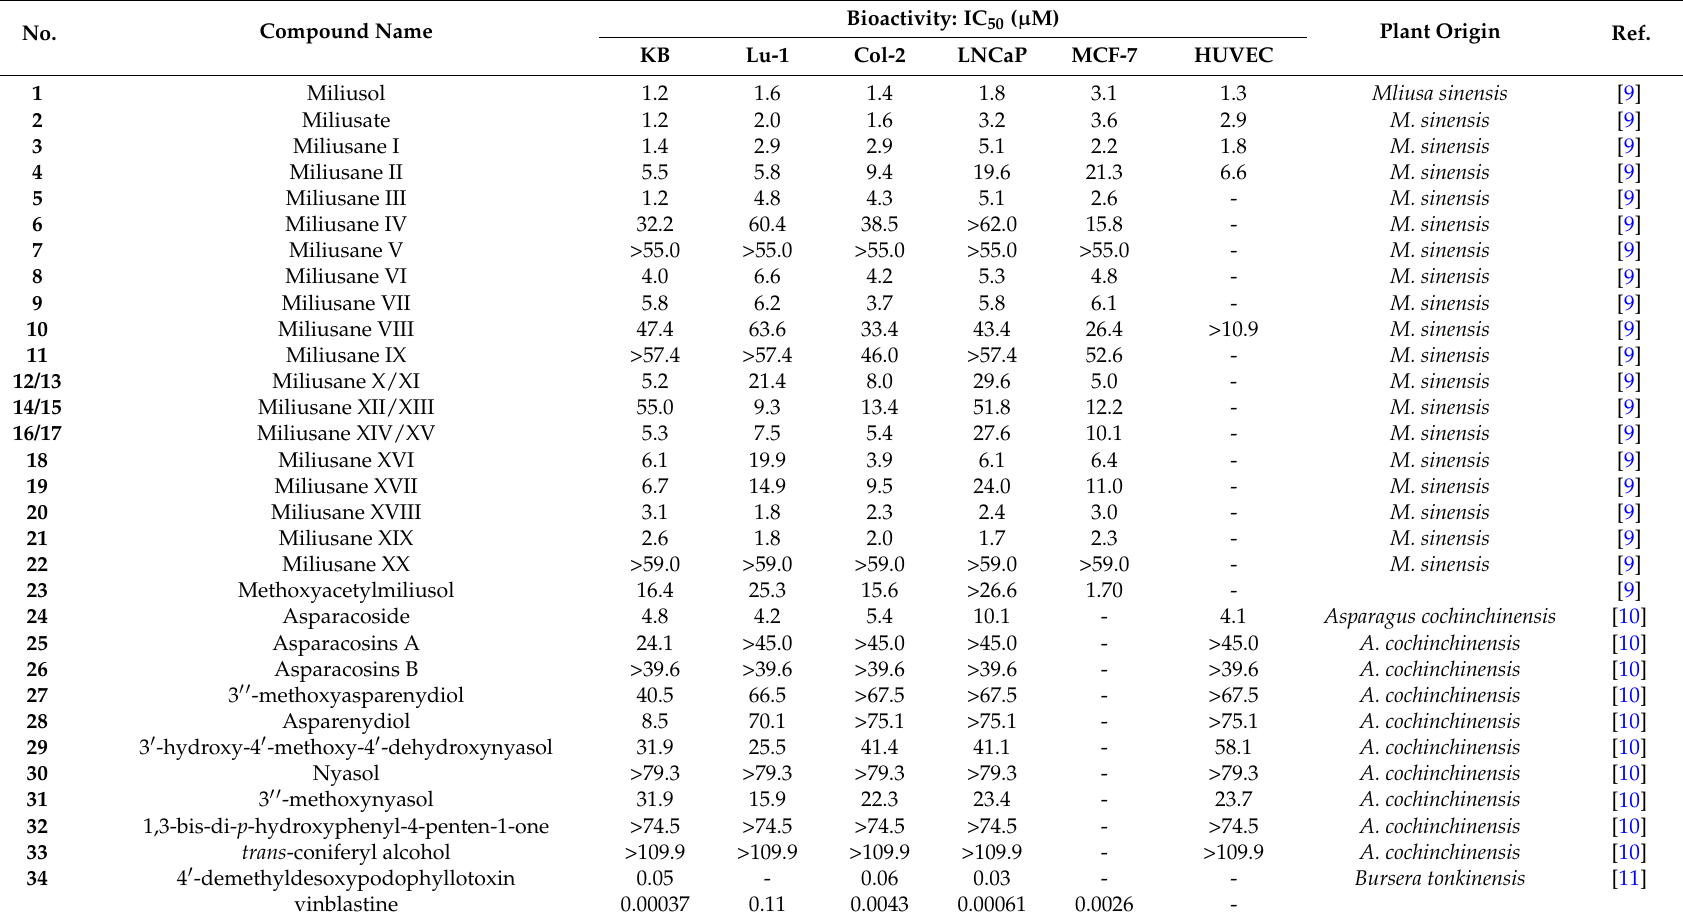
Table 1. The cell killing activity of compounds 1 – 34